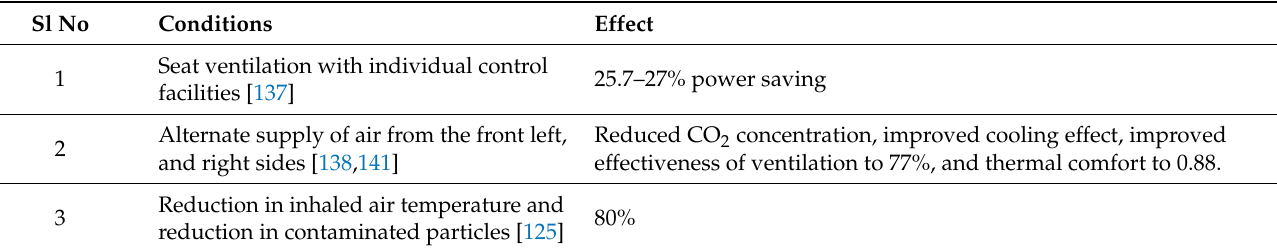
Table 12. Effect of personalized